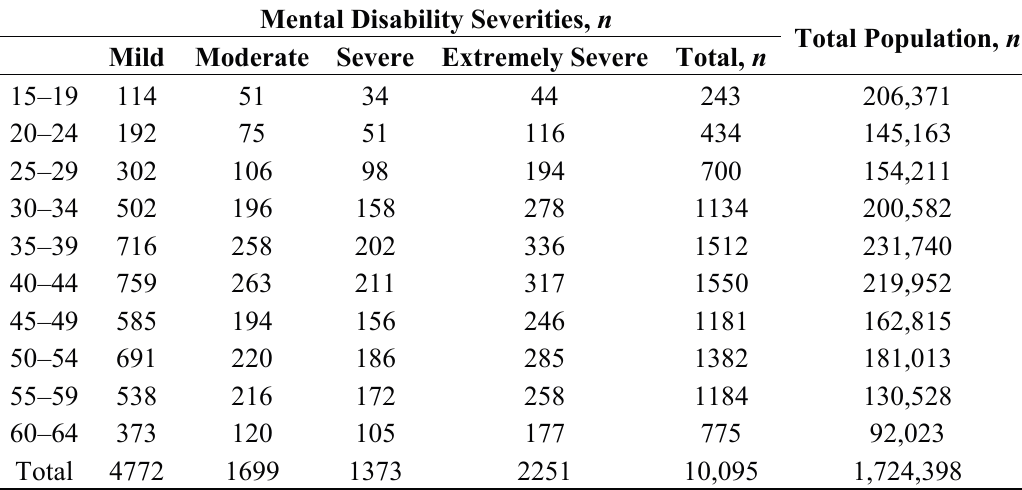
Table 2. Sample size of study population by age